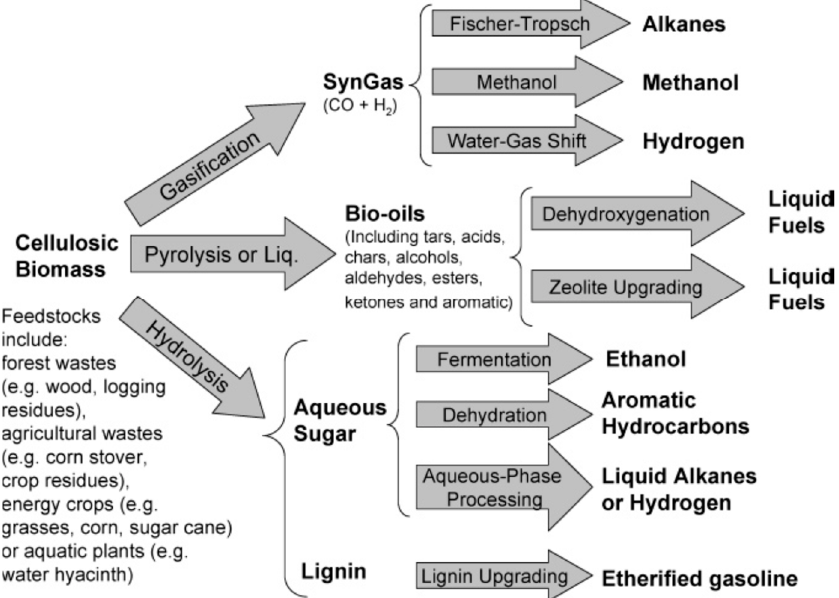
Figure 1. Strategies for the production of fuels from biomass, reproduced with permission from [7]. Copyright American Chemical Society,